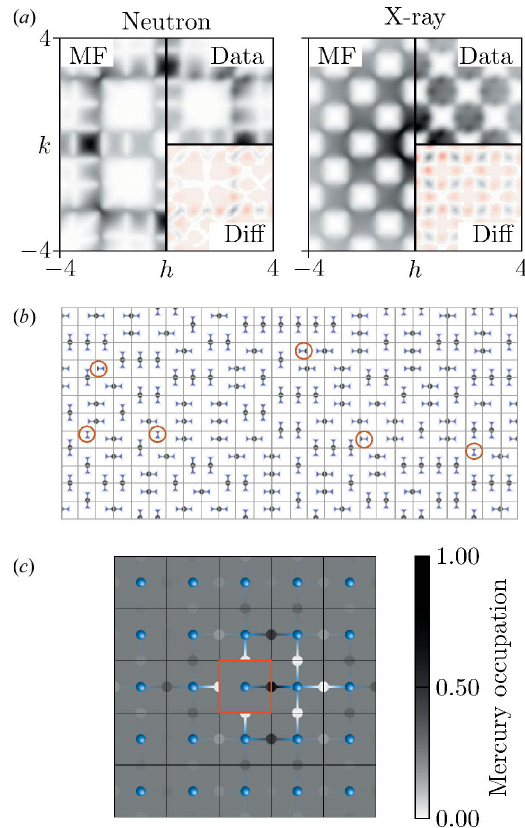
Figure 3 ( a ) Two-dimensional neutron and X-ray diffuse scattering calculated from the MF refinement (left) are compared with the calculated data (top right). The lower right-hand corner shows the difference I MF (cid:6) I exp , where positive (negative) values are displayed on a white to black (red) colour scale. ( b ) A section of a sample configuration generated by a direct MC simulation driven by the pair-interaction Hamiltonian of equation (11) with (cid:3) j = 1.617. Instances where the tiles are not matched correctly are circled. ( c ) The correlation function of the configuration shown in panel ( b ) averaged for symmetry. A tile orientation III is chosen as a reference, indicated by the red box. The probabilities of the different orientations of the neighbouring tiles are indicated by the occupation probability of the Hg 1/2 according to the black and white scale shown on the right-hand side. The ammonia groups are indicated in blue for reference. The nearest- neighbour matching rules are fulfilled to a great extent, as can be seen by the white circles, representing forbidden orientations, that surround the red